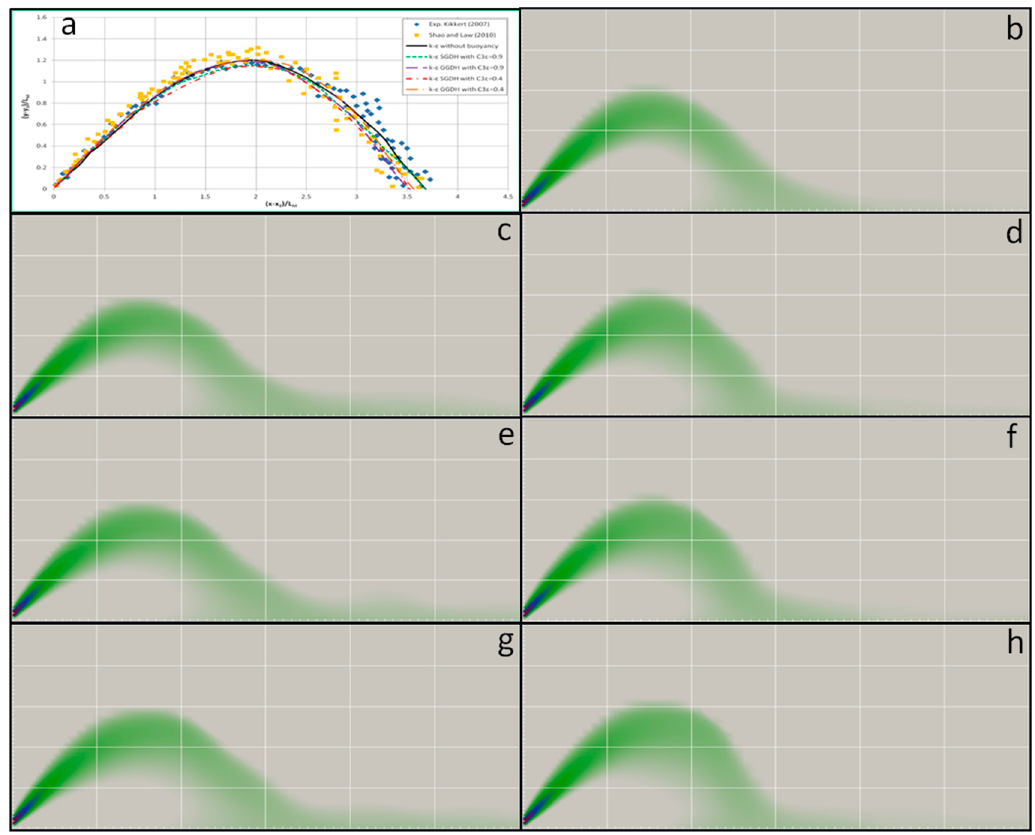
Figure 4. Overall discharge trajectory for 45° inclined dense jets (Source: [25]). ( a ) Centerline comparison (modeled vs. experiments); ( b ) standard k- ε ; ( c ) modified k- ε with SGDH, C 3 ε = 0.9; ( d ) modified k- ε with GGDH, C 3 ε = 0.9; ( e ) modified k- ε with standard Boussinesq gradient diffusion hypothesis (SGDH), C 3 ε = 0.6; ( f ) modified k- ε with general gradient diffusion hypothesis (GGDH), C 3 ε = 0.6; ( g ) modified k- ε with SGDH, C 3 ε = 0.4; ( h ) modified k- ε with GGDH, C 3 ε = 0.4.